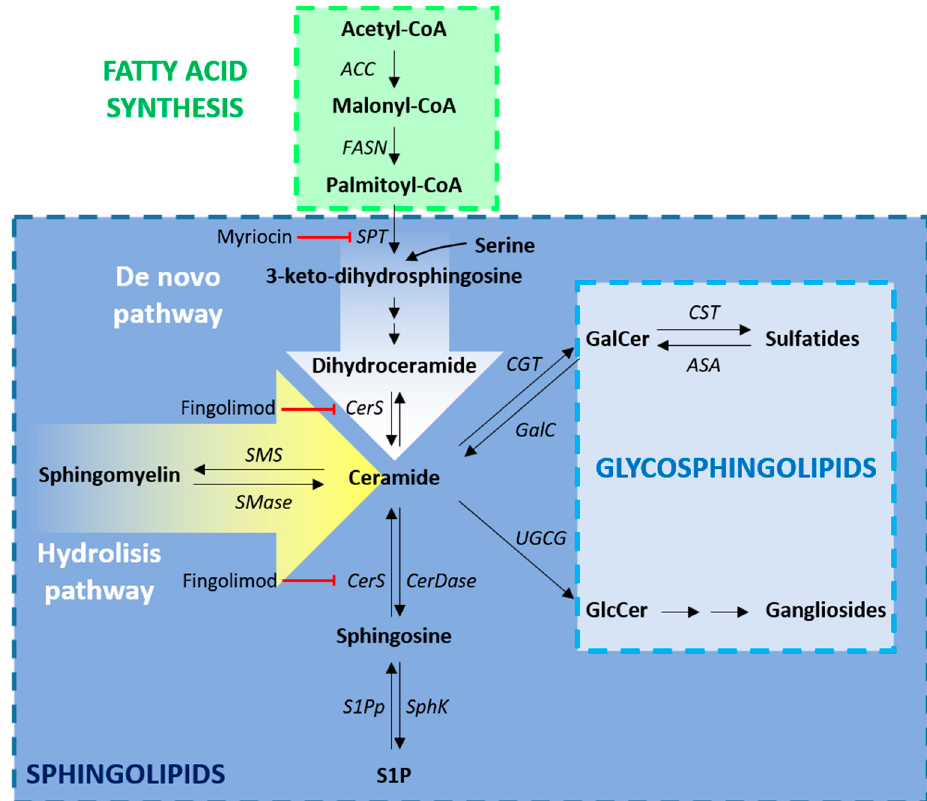
Figure 1. Lipid biosynthesis. Schematic overview of the pathways involved in the synthesis of fatty acids (FAs), sphingolipids and glycosphingolipids. For FA biosynthesis (green box), acetyl-CoA is converted into malonyl-CoA by ACC. The repeated condensation of acetyl-CoA and malonyl-CoA by the multifunctional enzyme FASN leads to the generation of palmitic acid, a fully saturated 16-carbon FA. The synthesis of ceramides (blue box) can occur via 2 distinct pathways: the de novo pathway (white arrow), that begins with the transamination of palmitoyl-CoA by SPT via a condensation reaction with serine and the hydrolysis pathway (yellow arrow), that synthesizes ceramide utilizing sphingomyelins as substrates through the action of SMase. Furthermore, ceramides can be obtained from sphingosine, through the action of CerS, and from GalCer, through GalC. Ceramides serve as precursor for the biosynthesis of the glycosphingolipids (light blu box), sphingomyelin and